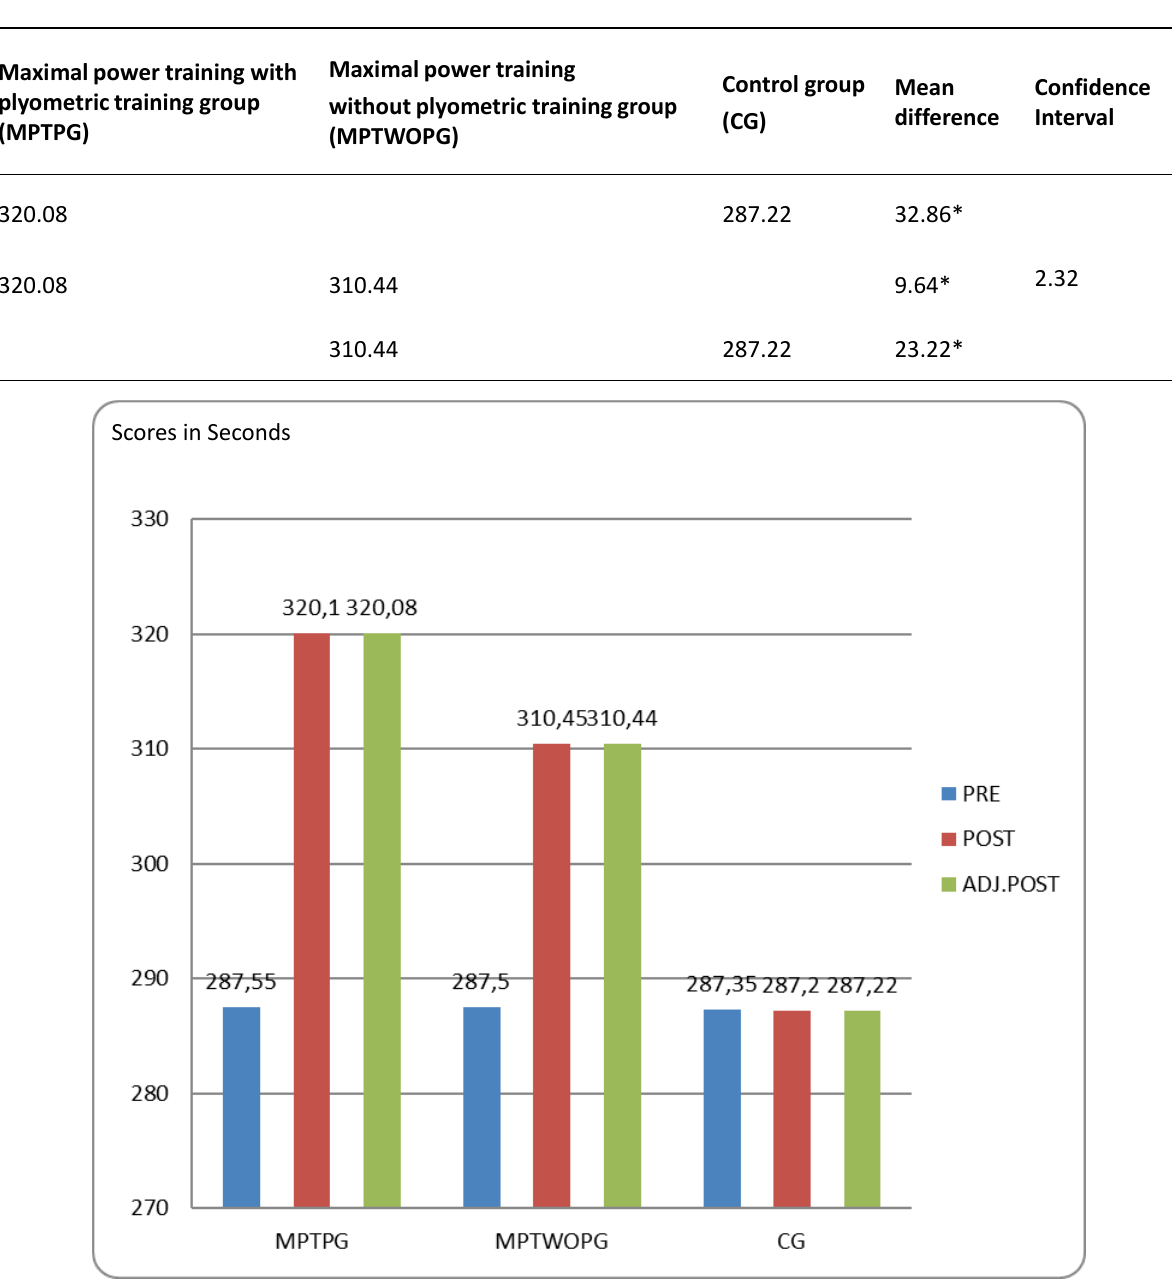
Figure 2. Upper Body Power